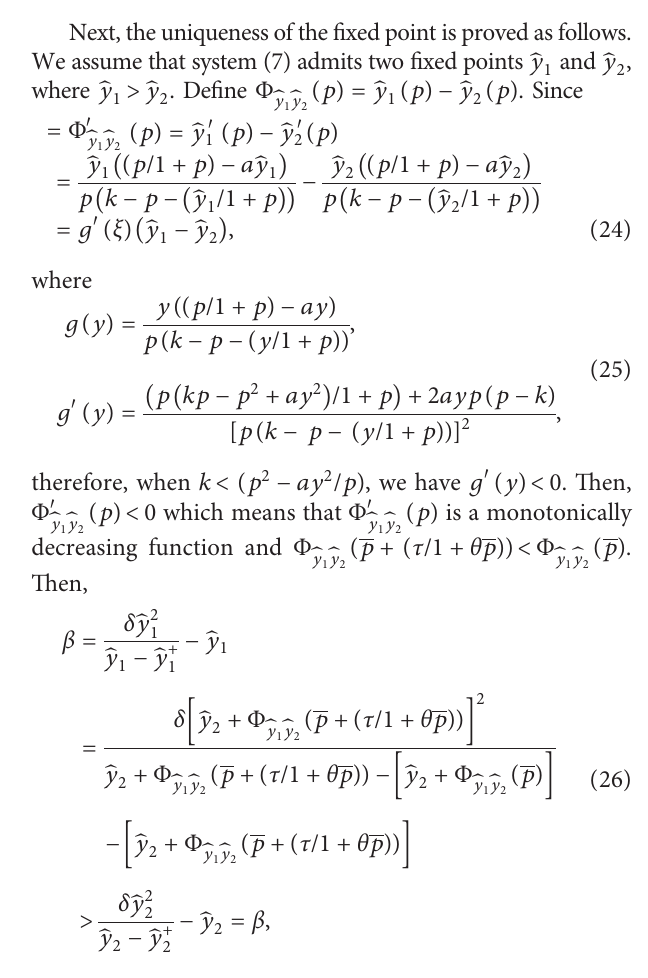
Figure 3: Image of Poincar´e map F (a) b � 0.7. (b) b �